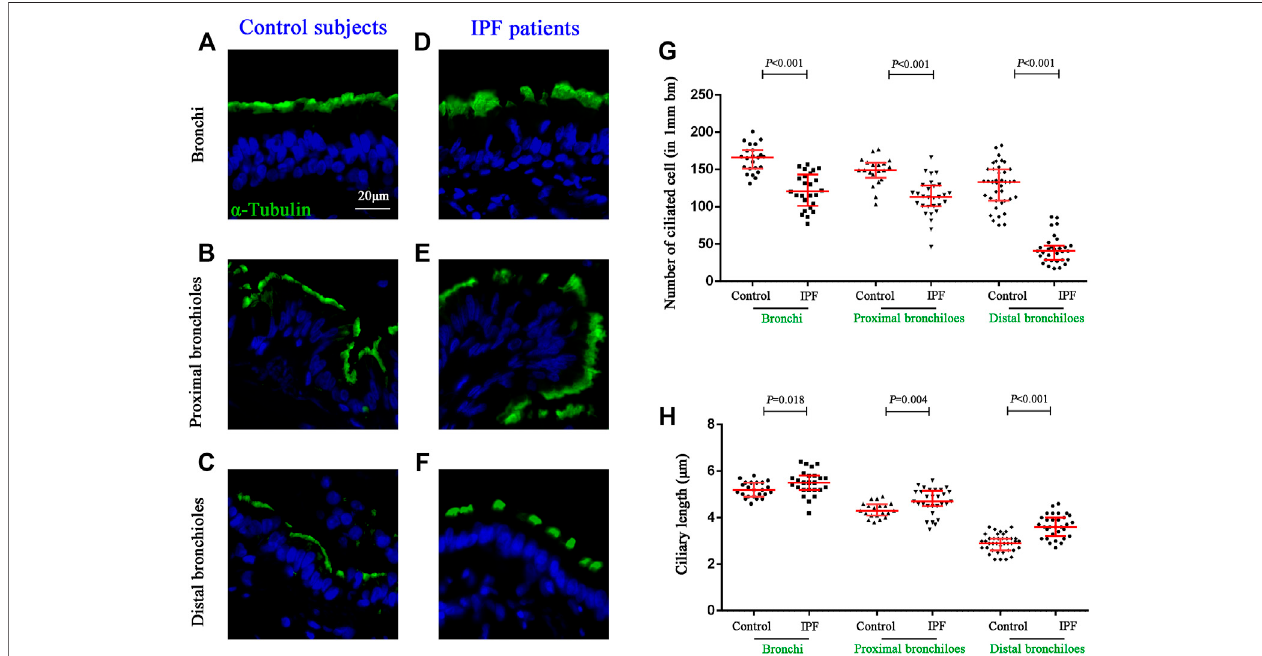
FIGURE3| Quanti fi cationofciliatedcellsandciliarylengthinconductingairways.IFstainingfor α -tubulin(stainedingreen)indifferentcompartmentsofconducting airwayincontrolsubjects (A – C) andIPFpatients (D – F) .Themediannumberofciliatedcellswassigni fi cantlyreducedinallthreeairwaycompartments (G) ,alongwiththe signi fi cant increase of ciliary length (H) in IPF patients as compared to the controls, respectively. DAPI labeling of nuclei (blue). DAPI, 4 ′ ,6-diamidino-2-phenylindole; IF, immuno fl uorescence; IPF, idiopathic pulmonary fi brosis.